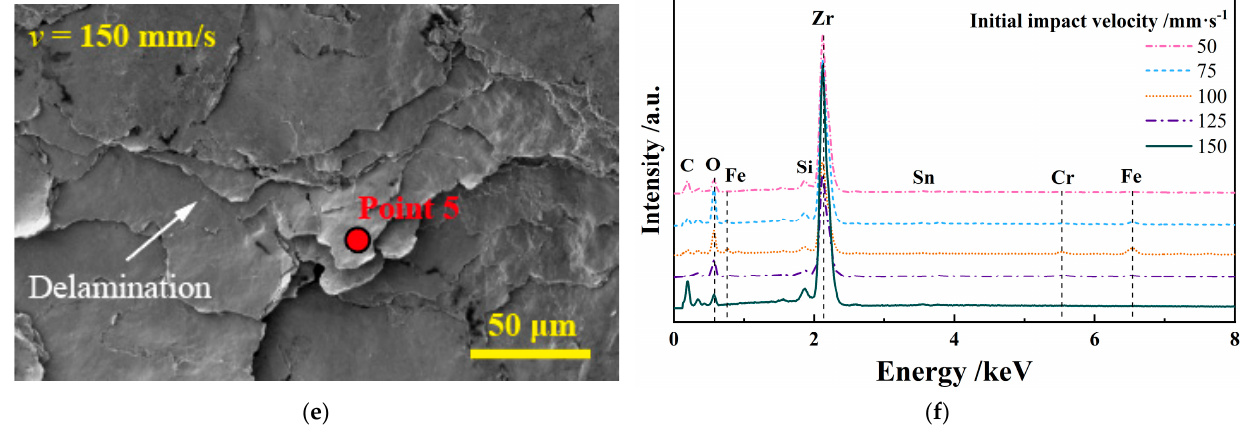
Figure 6. SEM morphology and EDS of wear scar center under varying initial impact velocities. ( a ) V = 50 mm/s, ( b ) V = 75 mm/s, ( c ) V = 100 mm/s, ( d ) V = 125 mm/s, ( e ) V = 150 mm/s, and ( f ) EDS.